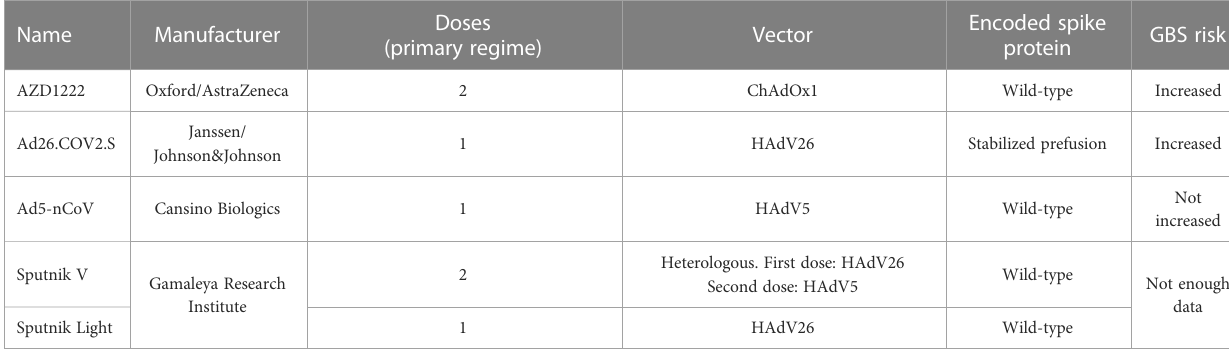
TABLE 1 Authorized COVID-19 vaccines using adenoviral